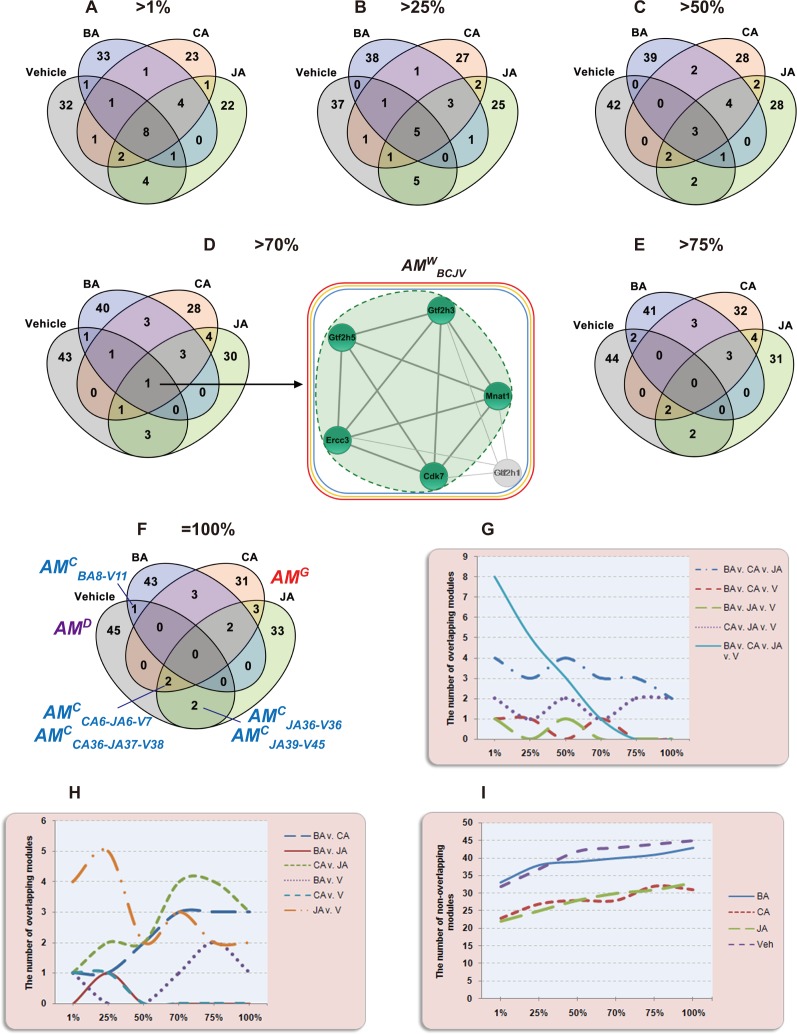
Different degrees of overlaps between modules of different treatment groups.(A-F) Six levels of similarity reflect the degree of overlaps between modules of different treatment groups, including Snef >1%, >25%, >50%, >70%, >75%, and = 100%. (D) The WAM identified among the four groups. When Snef>70%, AMWBCJV was first identified among the four groups. The green dashed area indicates the AM 10 in the BA group (AMBA10). The areas within the blue, orange and red squares represent AM 6 in the CA group (AMCA6), AM 6 in the JA group (AMJA6) and AM 7 in the vehicle group (AMV7), respectively. (F) Five CAMs were identified, namely AMCBA8-V11, AMCJA36-V36, AMCJA39-V45, AMCCA6-JA6-V7, and AMCCA36-JA37-V38. (G and H) The changing trends of the number of overlapping modules between groups. (I) The changing trends of the number of non-overlapping modules between groups.